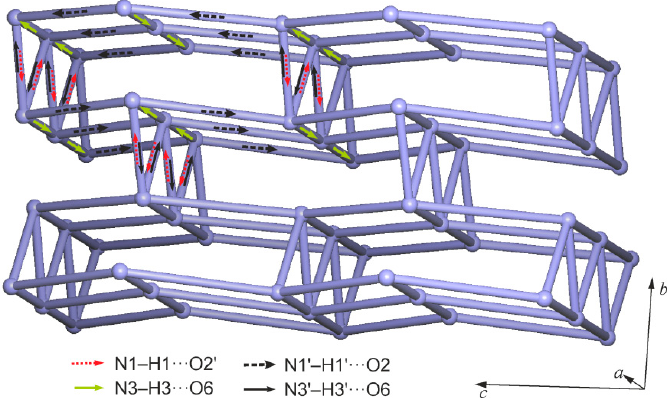
Figure 6. Graph according to ref. [21] for the HBS of 2 with the symbol F6 4 [3 3 .4 6 .5 5 .6- sxd ].